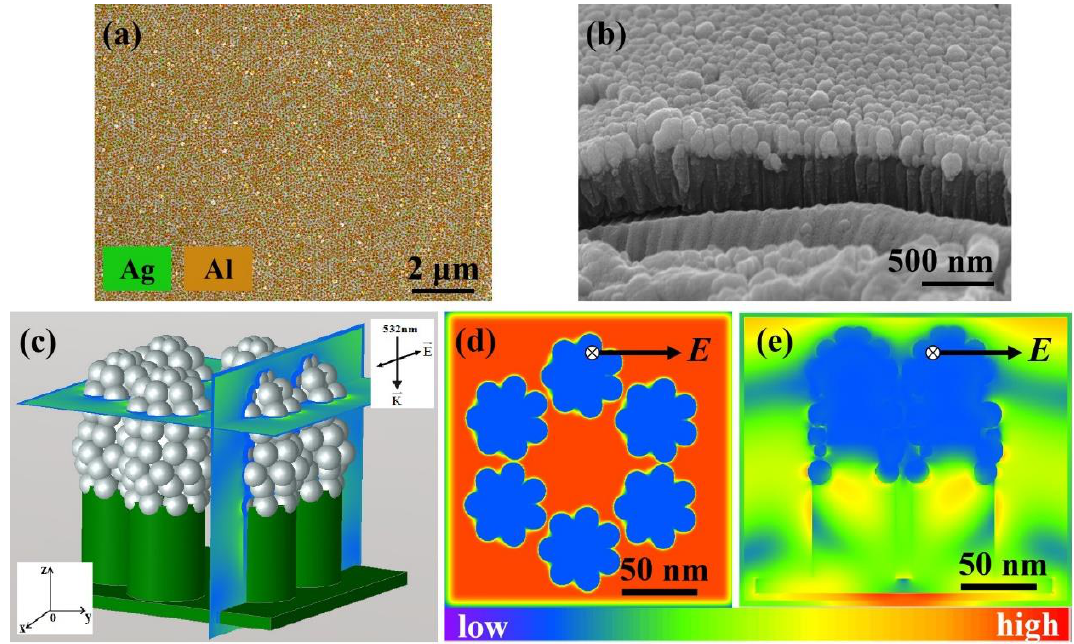
Figure 5. ( a ) EDX mapping of the Ag 20 -AAO nanoarray; ( b ) cross-section view FE-SEM image of the Ag 20 -AAO nanoarray; ( c ) 3D-FDTD model of the Ag 20 -AAO nanoarray; the spatial distributions of the electromagnetic field intensity of the Ag 20 -AAO nanoarray in the ( d ) x-y plane and ( e ) y-z plane.